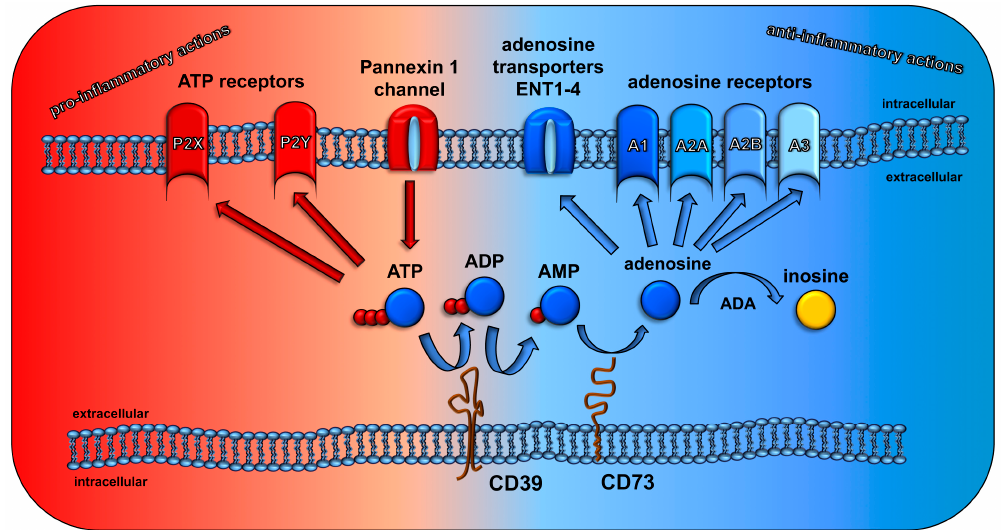
Figure 1. Purinergic Signaling. ATP can be released uncontrolled into the extracellular room by damaged or dead cells or actively via Pannexin1 channels. If ATP is released into the extracellular room multiple processes can take place. It can bind to different ATP receptors (P2 receptors) and in consequence pro-inflammatory signaling cascades will be induced. On the other hand, extracellular ATP can be rapidly converted to adenosine via two membrane bound ecto-nucleotidases CD39 and CD73. Binding to one of four different receptors adenosine exerts mostly immunoregulatory effects. Alternatively, extracellular adenosine can be shuttled into target cells via adenosine transporters or is converted via the adenosine deaminase to inosine.